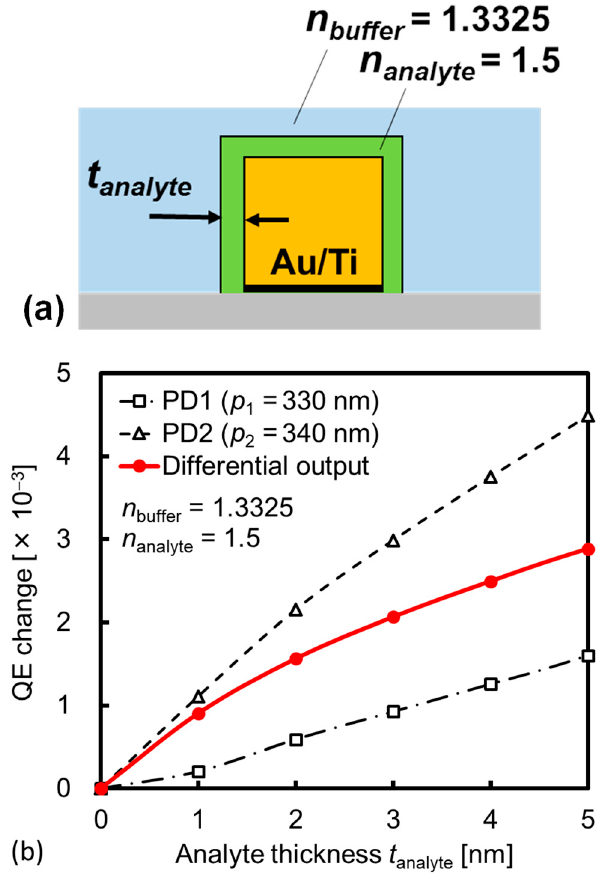
Figure 15. ( a ) Schematic of homogenously deposited layer on the surface of gold (Au) line of SP antenna for FDTD estimation, and ( b ) simulated QE change as a function of analyte thickness.